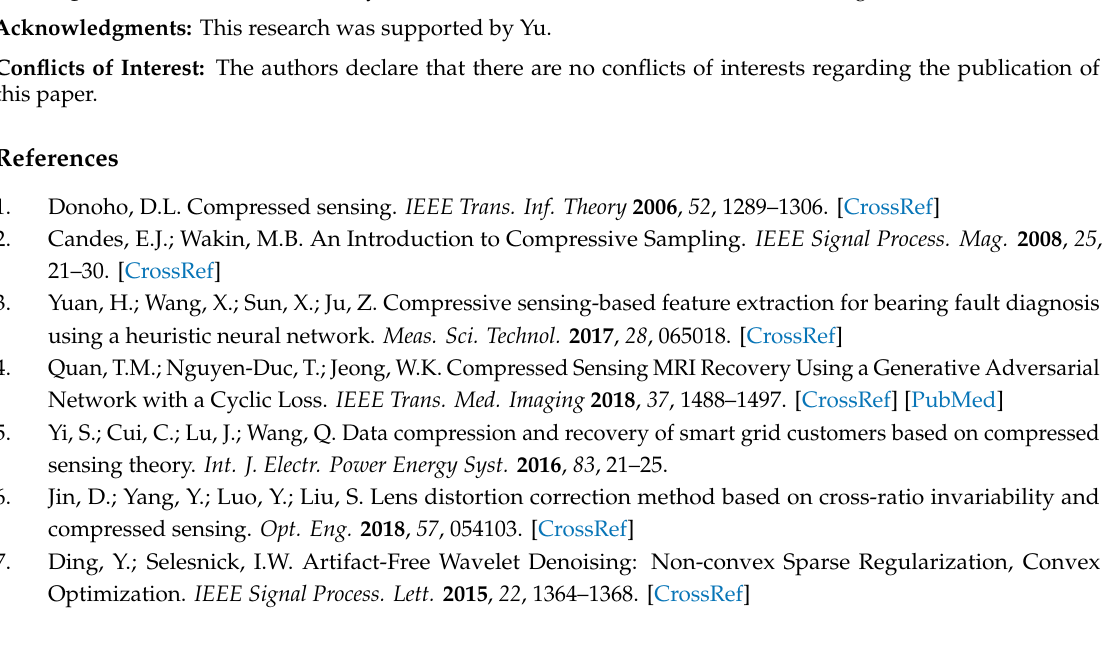
Figure 14. Recovery effect of the six methods on the Boat image. ( a ) original image; ( b ) noisy image; ( c ) OMP; ( d ) StOMP; ( e ) BP; ( f ) L0GP; ( g ) L0MN; ( h ) L0RCD. Table 2. The quantitative results (signal to noise ratio (SNR)/Time consumption(s)) of the six algorithms. Algorithm Lena Cameraman